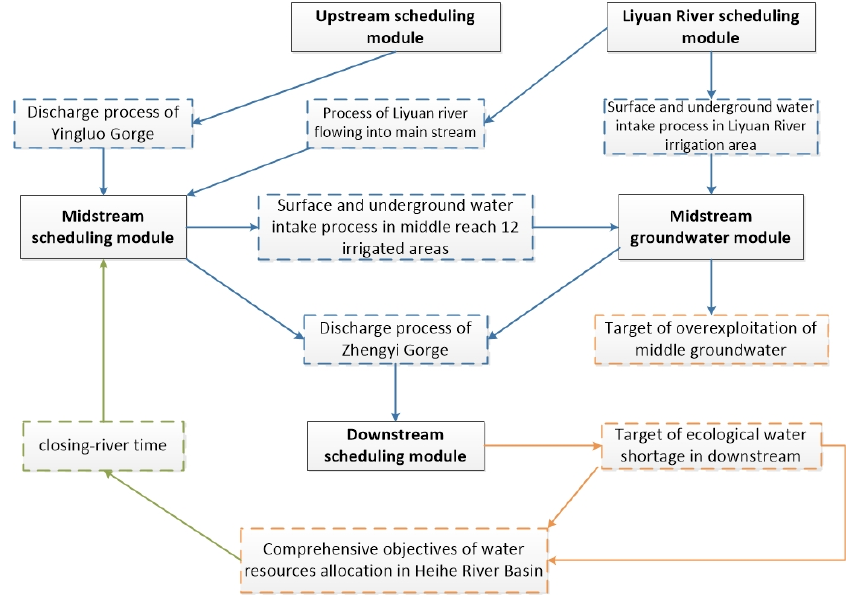
Figure 6. Operation process of water resource allocation model.